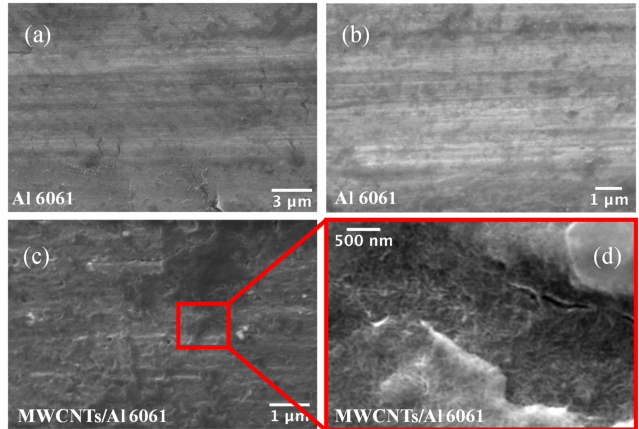
Figure 3. ( a , b ) SEM micrographs for Al 6061 substrate used for electrodeposition of MWCNTs. ( c , d ) Micrographs of the MWCNTs / Al 6061 samples after the electrodeposition process at 3 V during 20 min, using the 0.2 mg / mL solution. Notice some regions in which the MWCNTs tend to agglomerate over the surface of the Al 6061 substrate. Furthermore, these SEM images indicate a varying surface-coating quality depending on the applied EPD parameter values which agree with the results found in Reference